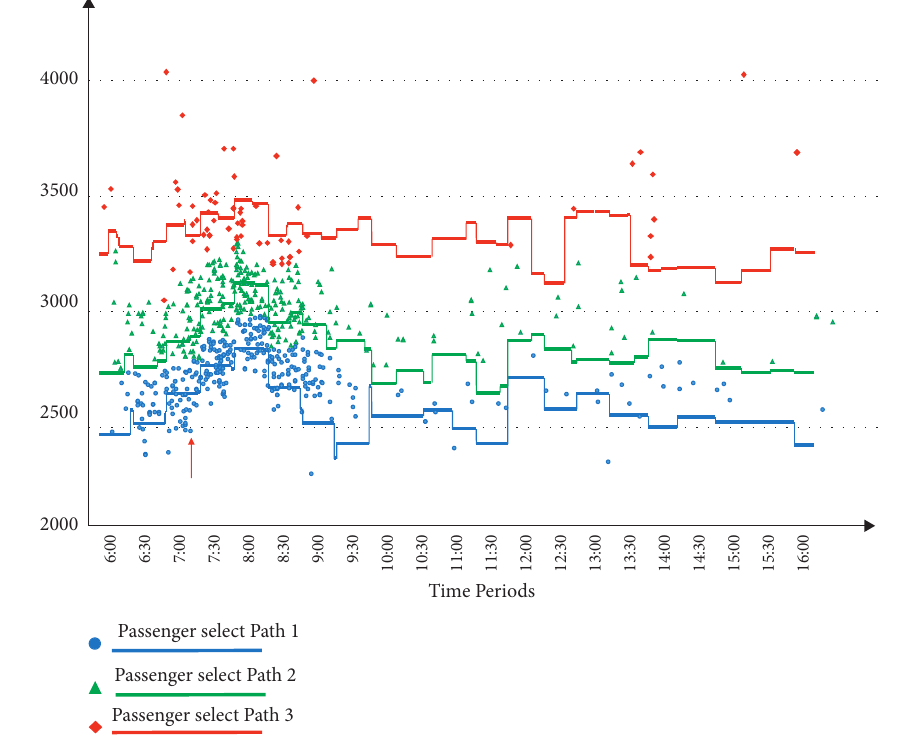
Figure 7: Path travel time and passenger path inference results. Table 4: Comparison of path inference